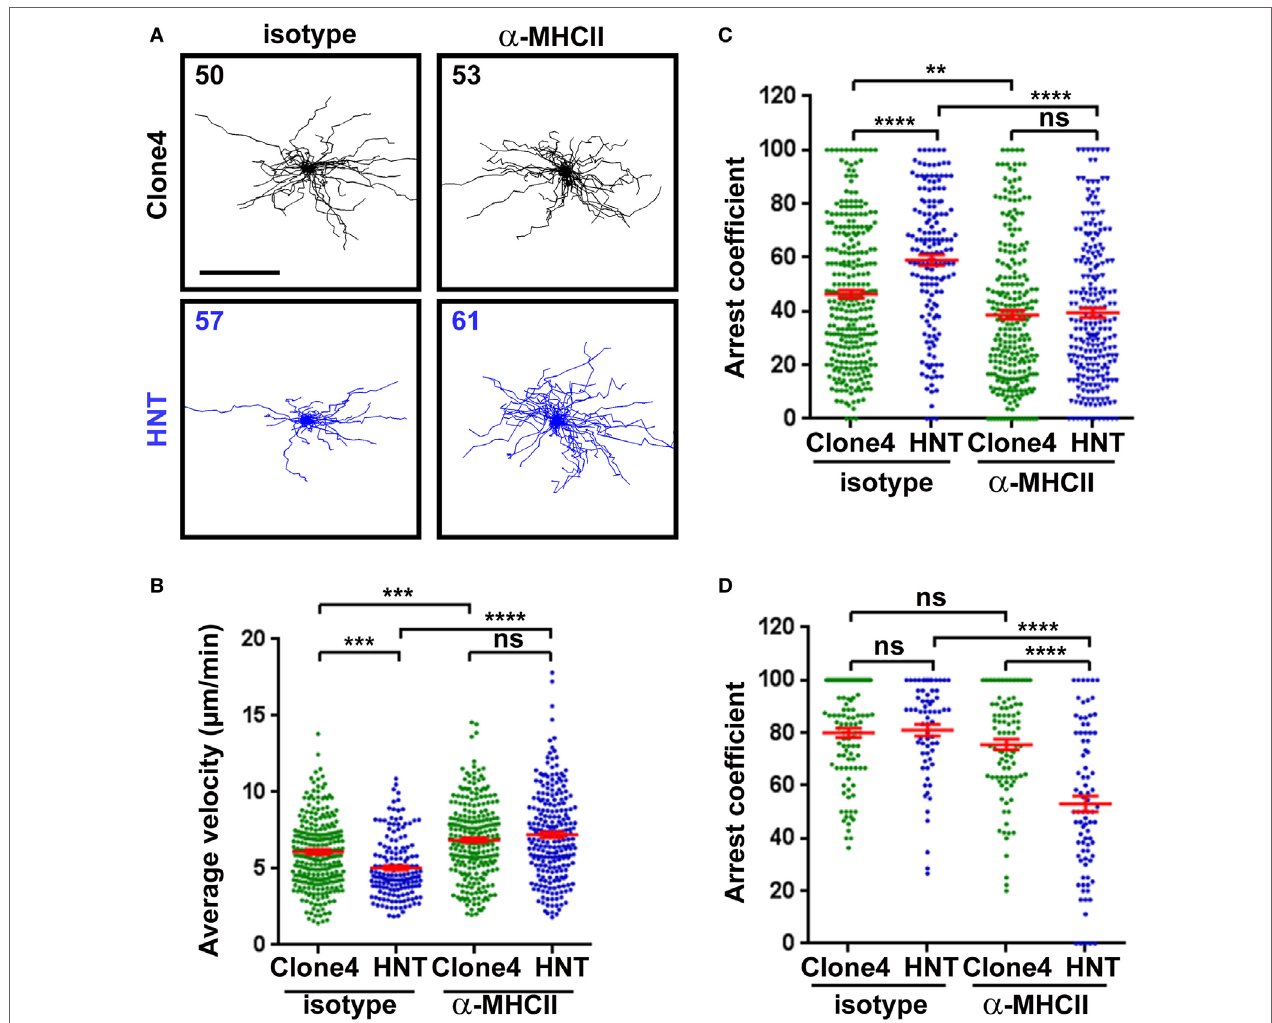
FigUre 3 | Major histocompatibility complex (MHC) class II-dependent CD4 + T cell arrest in the pancreas. (a) Irradiated InsHA-mCherry mice transferred with clone 4-GFP CD8 + and HNT-CFP CD4 + T cells were subjected to intravital microscopy on day 8. XY projections of T cell tracks over 17.5 min are depicted. Recording started > 1 h following isotype-matched control or anti-MHCII antibody i.v. injection (scale: 100 µm) (Video S6 in Supplementary Material). Numbers indicate track numbers in movies. (B) Average T cell velocities in the exocrine tissue at day 8 posttransfer ( n = 3 mice/condition; 1–3 movies/mouse, one-way ANOVA). (c,D) Arrest coefficients in exocrine ( c) or endocrine (D) tissues at day 8 ( n = 3 mice/condition; 1–3 movies/mouse in areas with comparable levels of infiltration, one-way ANOVA). Dots correspond to individual T cell